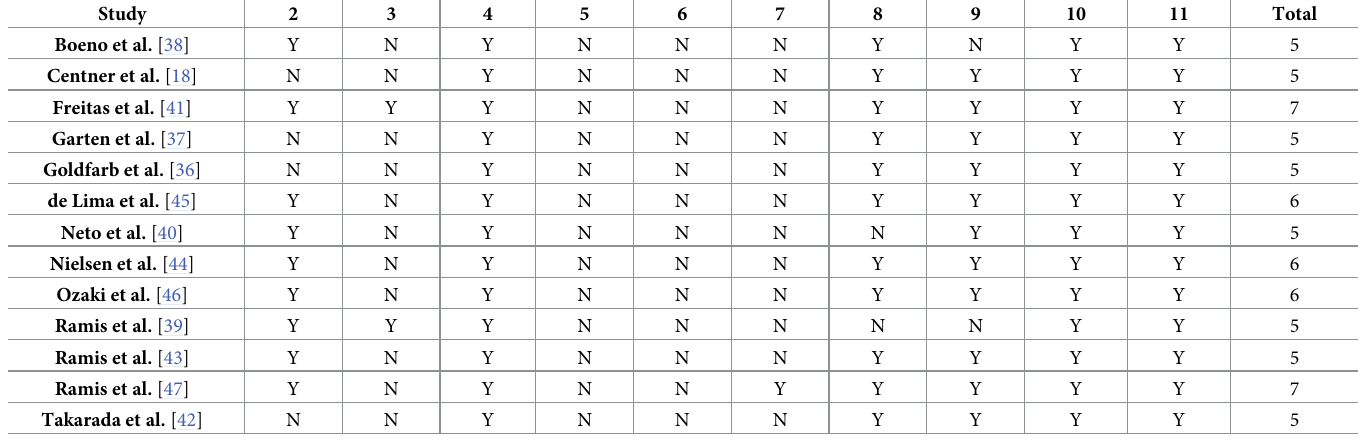
analyzed were sulfhydryl / thiols [39,43,45] and nitric oxide [38,46,47]. The measurement of nitric oxide in all studies was evaluated by concentration of nitrite and nitrate in the blood, as an index of endothelial nitric oxide synthase activity. Centner et al. [18] measured the total ROS generation with LLRE-BFR while Garten et al. [37] evaluated the activity of xanthine oxidase. Of the included studies, three trials (n = 59) [39,40,45] compared the post-exercise effect of lipid peroxidation between LLRE-BFR and HLRE. Our results, based on low certainty of evi- dence (downgraded due imprecision and risk of bias), demonstrates that LLRE-BFR produces significantly lower post-exercise lipid peroxidation products than HLRE with a large effect size (SMD = -0.95 CI 95%: -1.49 to -0.40, I 2 = 0%, p = 0.0007), see Fig 2. Only one trial (n = 11) analyzed changes in lipid damage markers 24 hours and 48 hours after exercise [39]. This study reported that LLRE-BFR produces significantly lower lipid peroxidation products (p = 0.02) at 24 hours post-exercise, but at the 48-hour sampling point, no statistically signifi- cant difference was reported (p > 0.05), see Table 3. All these findings are based on very-low certainty of evidence (downgraded due imprecision, inconsistency, and risk of bias). On the other hand, based on three studies comparing the effects of LLRE-BFR with LLRE, no signifi- cant differences were observed in lipid damage markers at any time point evaluated in this review with low certainty of evidence (downgraded due to risk of bias and imprecision). For more details, see Figs 2 and 3.